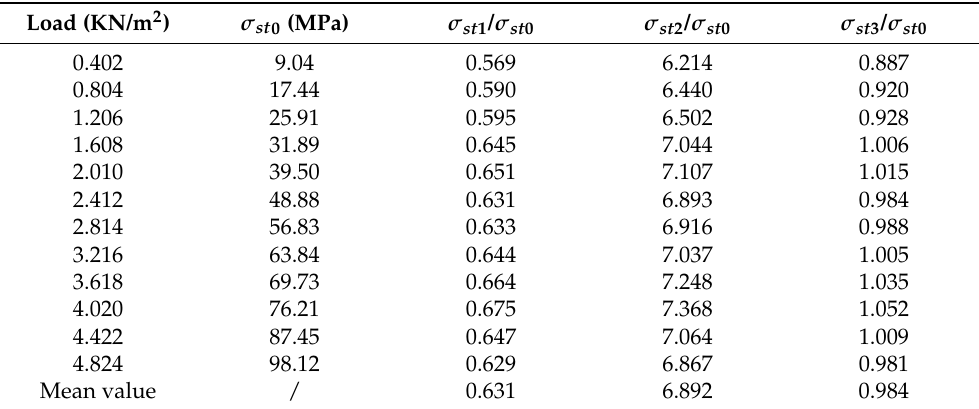
Table 10. Comparison of tensile stress at the lower flange of longitudinal light-gauge steel studs in mid-span. Load (KN/m 2